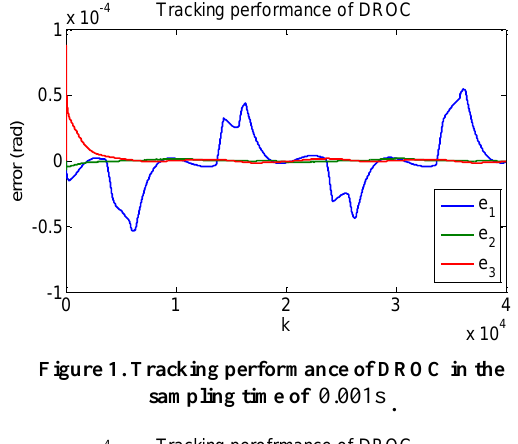
Figure 4. Tracking performance of DROC with initial error.